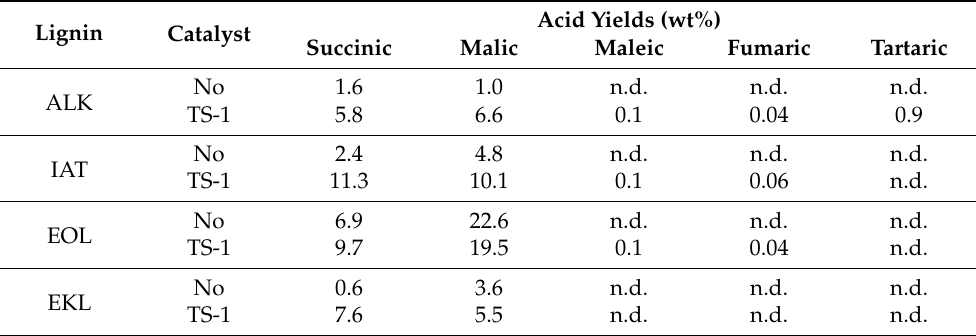
Table 2. Best C 4 -DCA yields for four industrial lignin oxidations for catalyzed and non-catalyzed wet peroxide oxidations using TS-1 catalyst